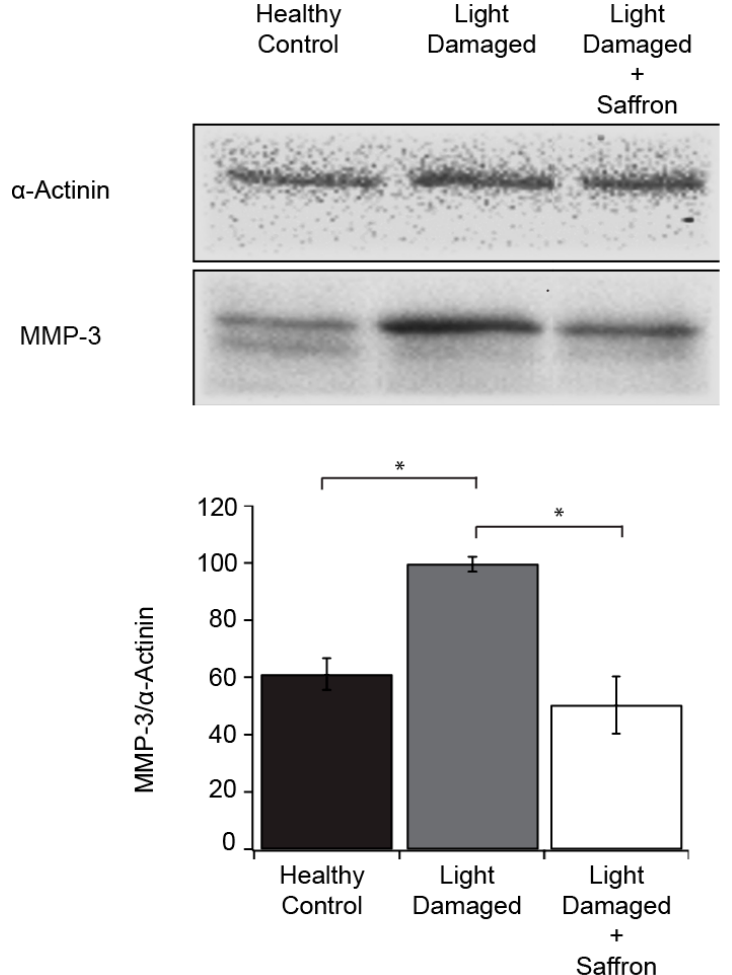
Figure 4. Western blot analysis of MMP-3 protein level in control, untreated and saffron treated light damaged retinas. The MMP-3 densitometric analysis normalized for α -Actinin shows that MMP-3 protein in saffron treated light damaged retinas is similar to that of control, and significantly reduced compared to the light damaged group. The mean ± SE is reported. (* = p < 0.05) .